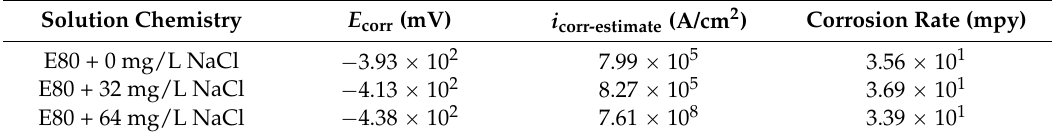
Figure 7. Effect of chloride on anodic polarization of MAS showing increase in current density with increasing chloride in E80. Table 5. Anodic polarization data showing the influence of chloride in simulated E80 fuel ethanol environment.